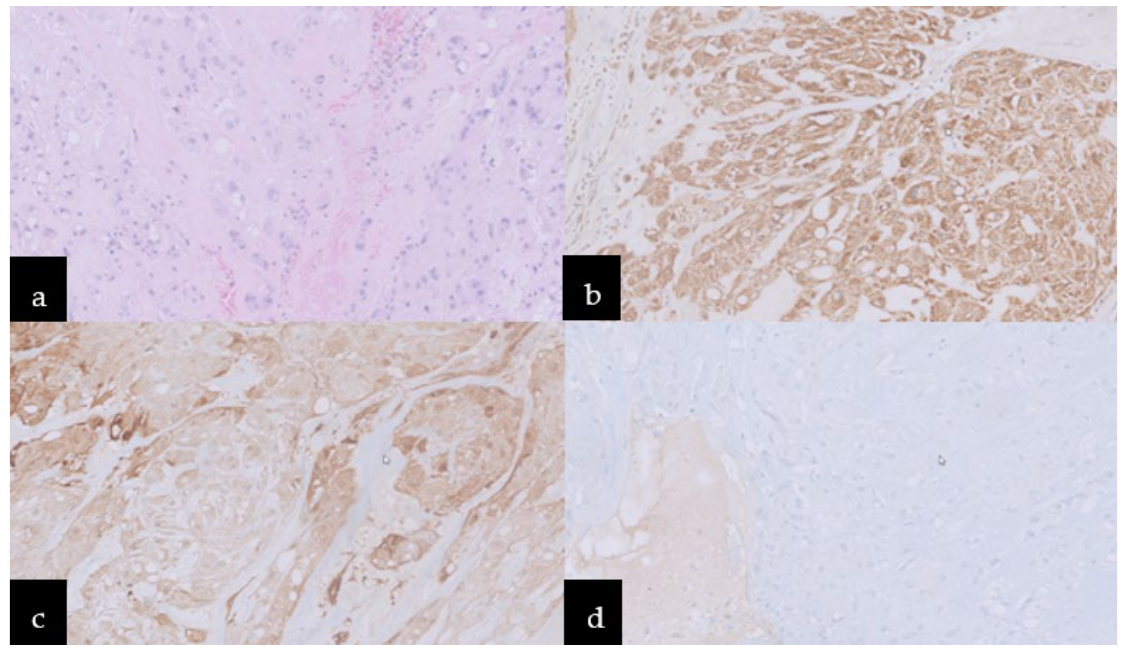
Figure 3. Microscopic images: ( a ) Hematoxylin–eosin stain, neoplastic cells with pale eosinophilic, cytoplasm vacuolated, arranged in cords separated by fibrovascular bands and myxoid matrix. Im- munoreactivity for ( b ) AE1/AE3, ( c ) S100, and ( d ) negative one for GFAP.